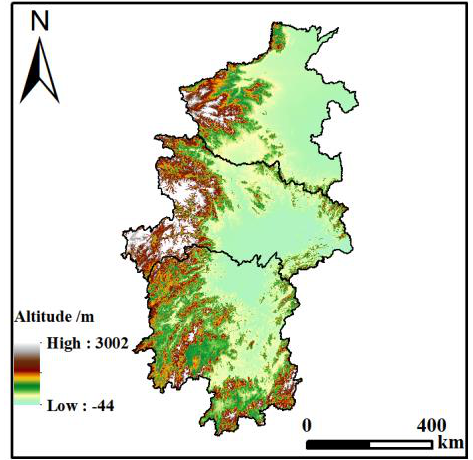
Figure 1. DEM spatial distribution map of 1 km × 1 km resolution in Central China.